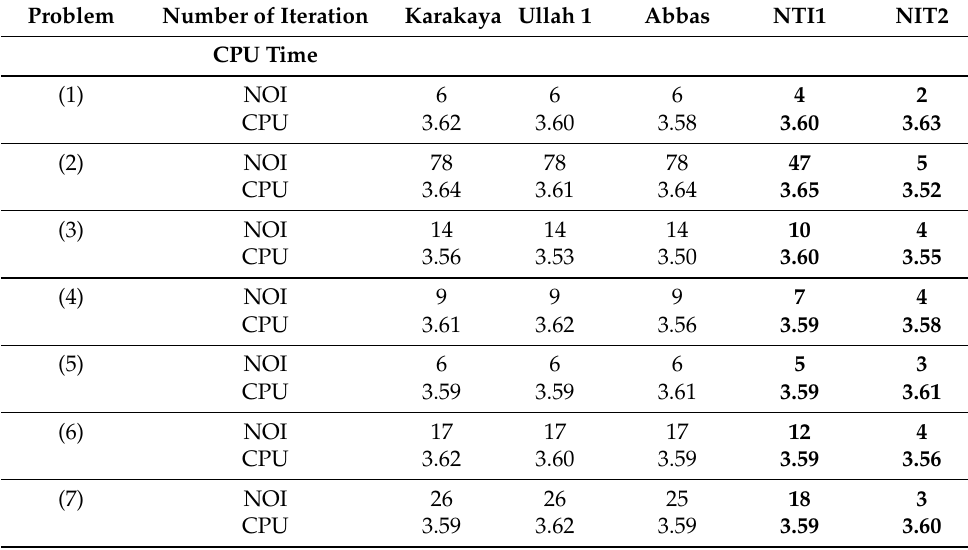
Table 5. Results of comparison of three-step methods on problems in Table 3. Problem